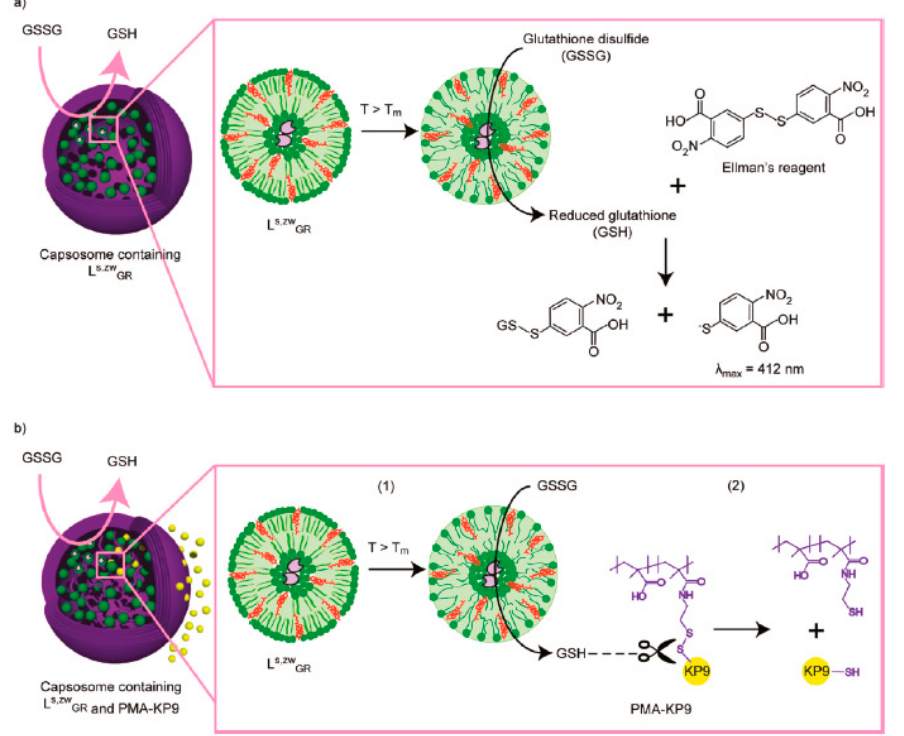
Figure 5. ( a ) Temperature-triggered catalysis of encapsulated glutathione reductase in the “free-floating” liposomal compartments of capsosomes, which reduces glutathione disulfide (GSSG) to its sulfhydryl form (GSH); ( b ) the release of encapsulated oligopeptides triggered by the catalytic activity of glutathione reductase in capsosomes. The production of GSH is measured using Ellman’s reagent as an indicator. The reduction of GSSG to GSH by the activity of encapsulated glutathione reductase in the liposomal subcompartments (1) facilitates the release of the encapsulated peptide due to the cleavage of disulfide bonds linking the polymer carrier (PMA) and the peptide (KP9) (2) (reproduced with permission from [83], Copyright 2011, American Chemical Society).